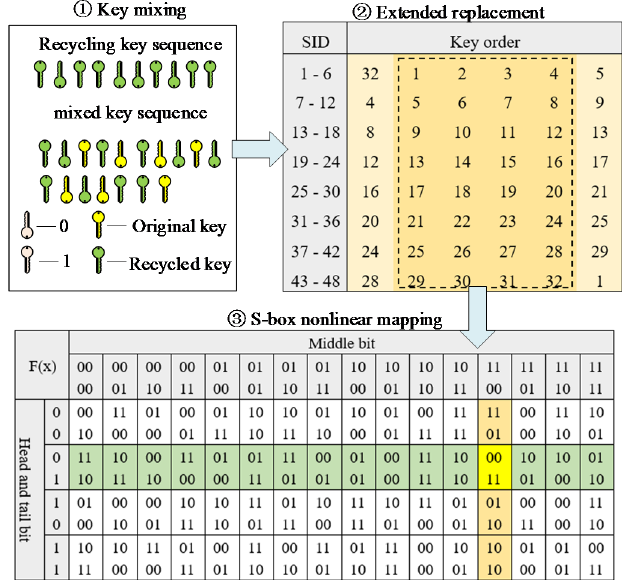
Figure 8. QKR post processing algorithm.